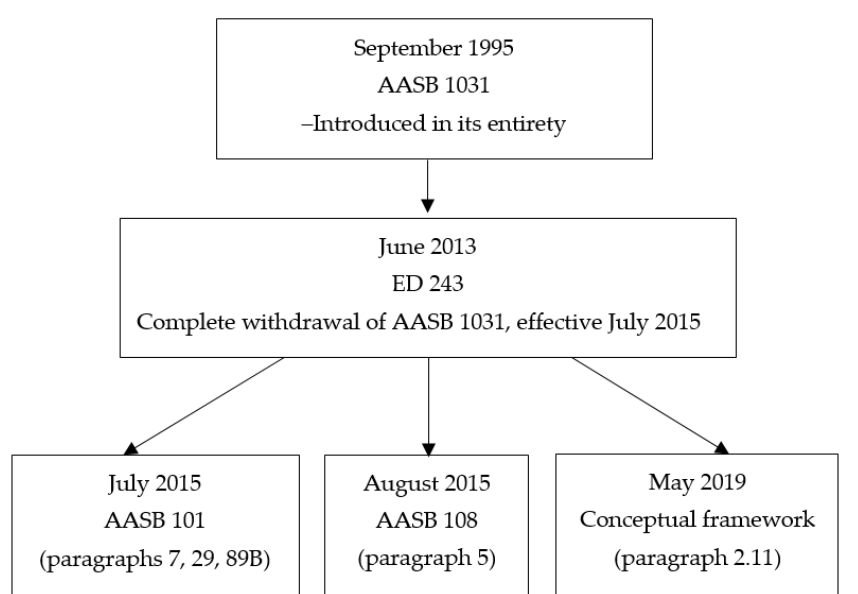
Figure 1. Evolution of the Materiality Concept and application in Australia.